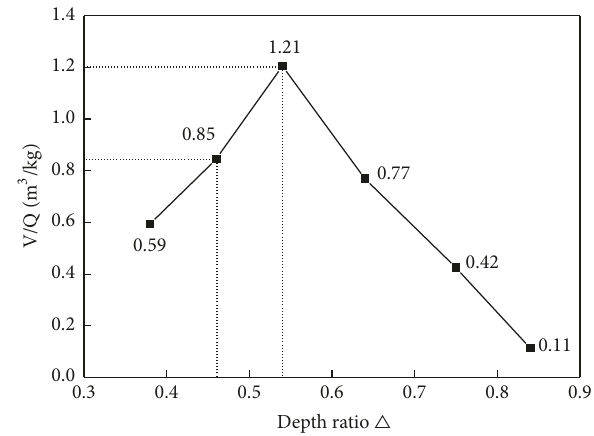
Figure 4: Curve of V/Q versus the depth